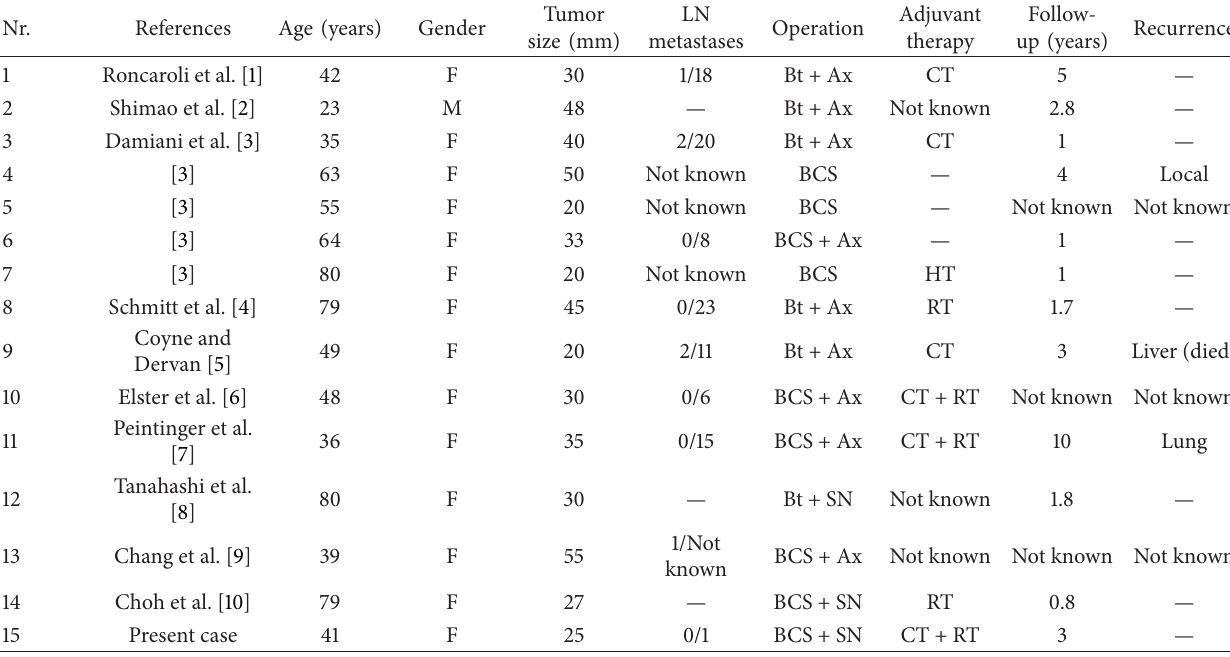
Table 1: Clinical characteristics of acinic cell carcinoma of the breast.